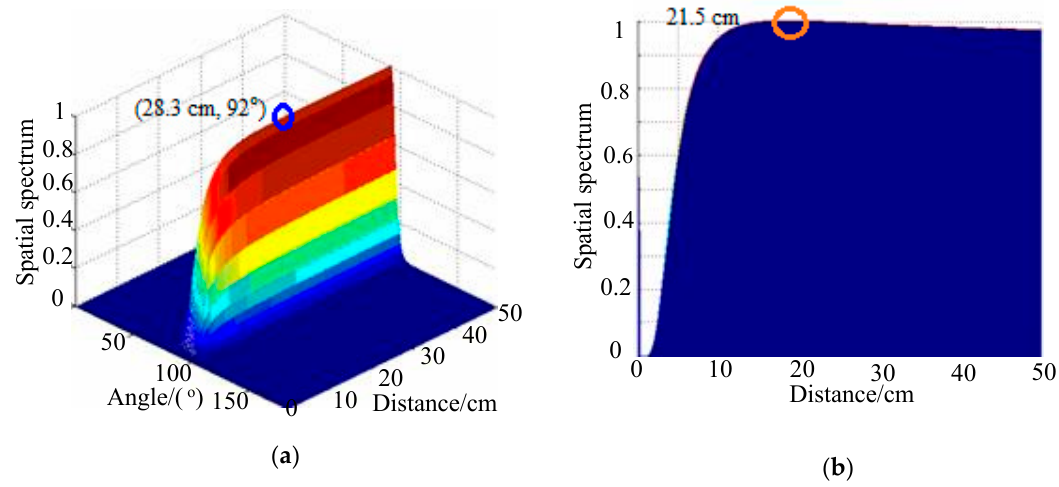
Figure 12. Spatial spectra of two methods when real impact occurs: ( a ) 2D-MUSIC algorithm; ( b ) TAM-MUSIC method.